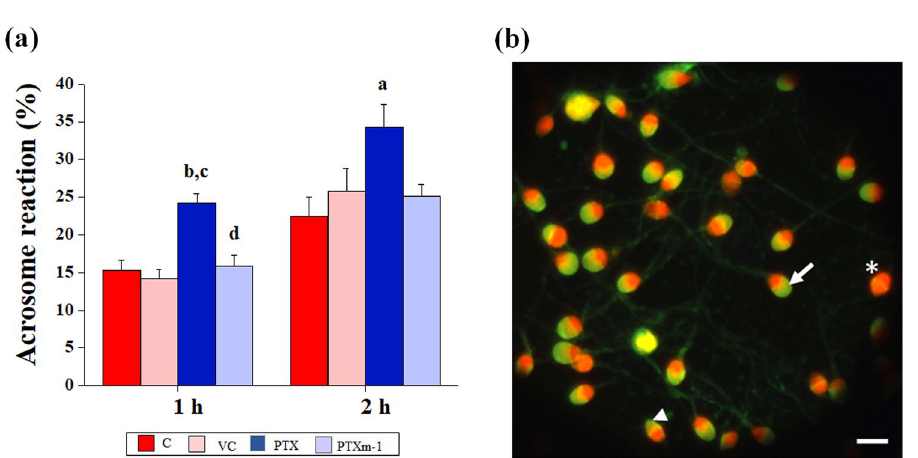
Figure 6. Effect of PTX and PTXm-1 in sperm wash media on the ability of spermatozoa to undergo acrosome reaction in normozoospermic samples assessed by calcium ionophore-induced acrosome reaction assay. (a) percentage of acrosome reacted spermatozoa at 1 h and 2 h after swim up (N = 28). ( b ) Representative image showing spermatozoa with intact acrosome (arrow), spermatozoa after partial acrosome reaction (arrow head) and acrosome reacted spermatozoa (asterix). Spermatozoa were stained with FITC (Fluoresciene isothiocynate) -conjugated Pisum sativum agglutinin and counterstained with propidium iodide. The error bar represents standard error to mean. a: P < 0.01, b: P < 0.001 compared to control; c: P < 0.001 compared to vehicle control; d: P < 0.001 compared to PTX at respective time. Magnification 400x; scale bar represents 10 µm. C: control; VC: vehicle control; PTX: pentoxifylline; PTXm-1: modified